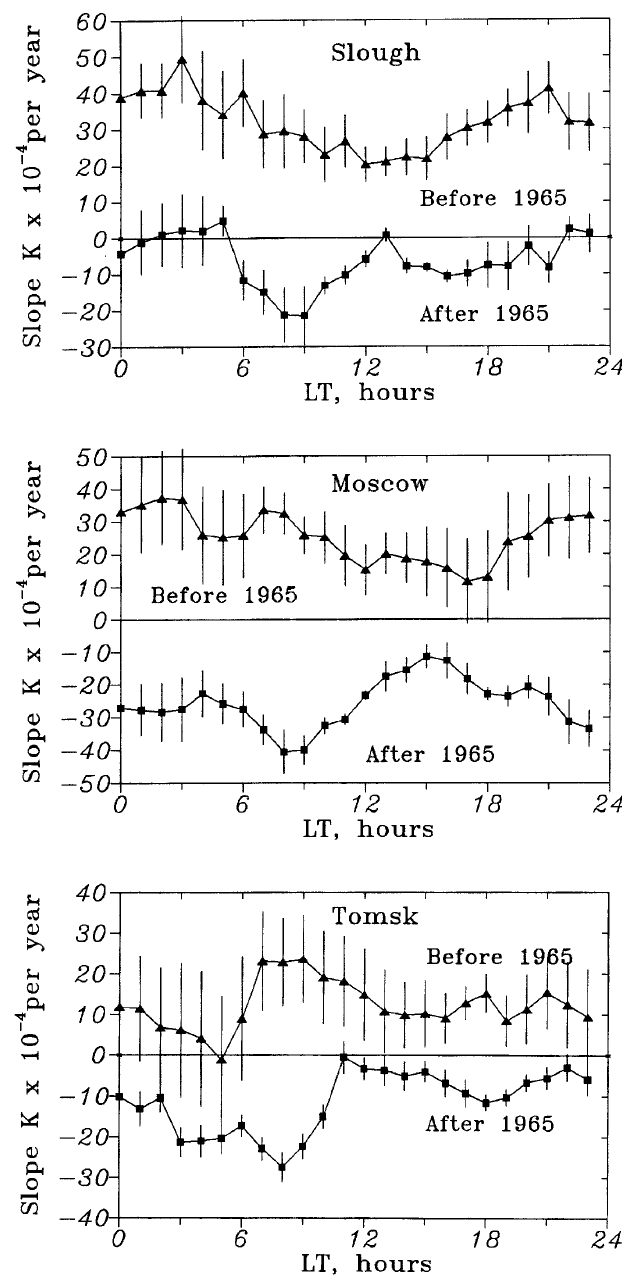
Fig. 5. Diurnal variation of annual mean slope K at three stations for the periods of decreasing (1947–1965) and increasing (1975–1991) geomagnetic activity. Note di(cid:128)erent signs of trends for the two periods. Error bars present the standard deviation of seasonal (over 12 months) scatter in the slope